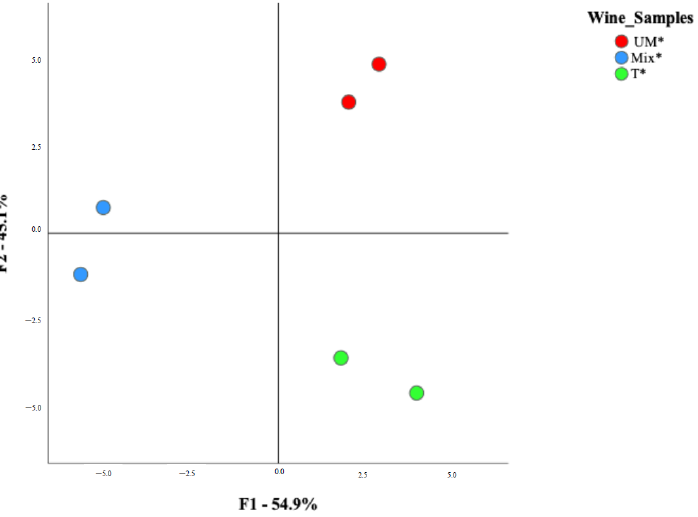
Figure 2. Score plot of the two first discriminant functions obtained after linear discriminant analysis (LDA) analysis of the different Antão Vaz wines.